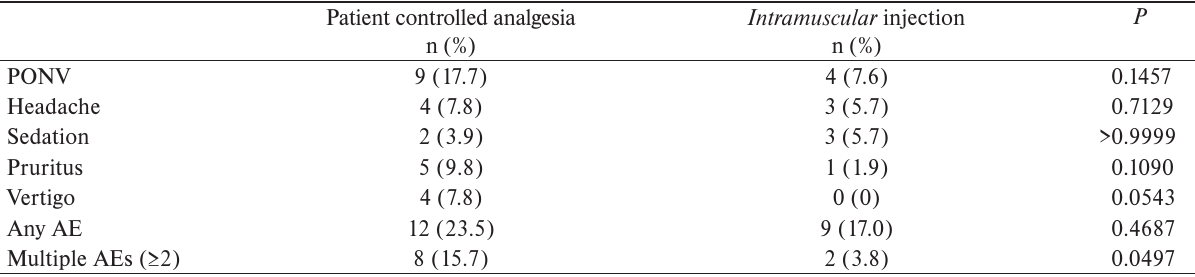
Table 3. Incidence of opioid-induced adverse effects.